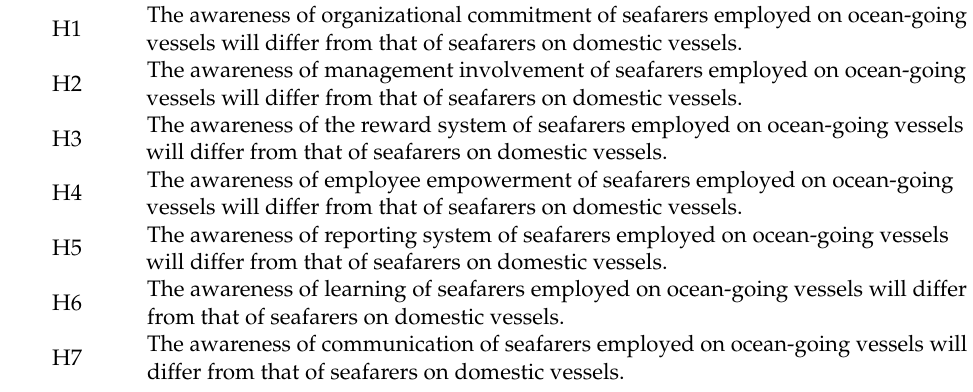
Table 4. The seven sub-hypotheses (H) (Source: Adopted from [7]).